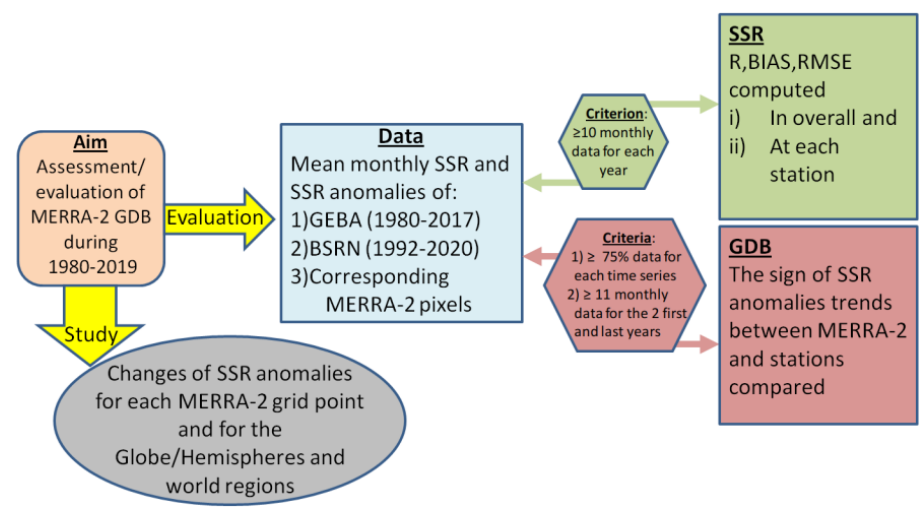
Figure 2. The steps of the applied methodology of assessment/evaluation of MERRA-2 GDB. Four (4) statistical indices were used to quantify the degree of agreement/disagreement between the MERRA-2 and reference stations’ GDB: the Pearson’s correlation coefficient (R), the Root Mean Squared Error (RMSE) and percent relative RMSE (RRMSE), the bias and relative bias; whose equations